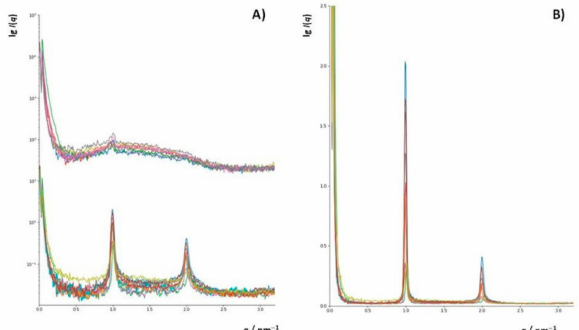
Figure 8. ( A ) SAXS curves (lg( I ) vs. q ) (raw data, not background-subtracted) of lipid solutions, separated (shifted verically) according to the nanostructure: (bottom) multilamellar structure (top), bilayers, and the rest of the material. ( B ) SAXS curves in linear plots ( I vs. q ) of lipid solutions showing the multilamellar